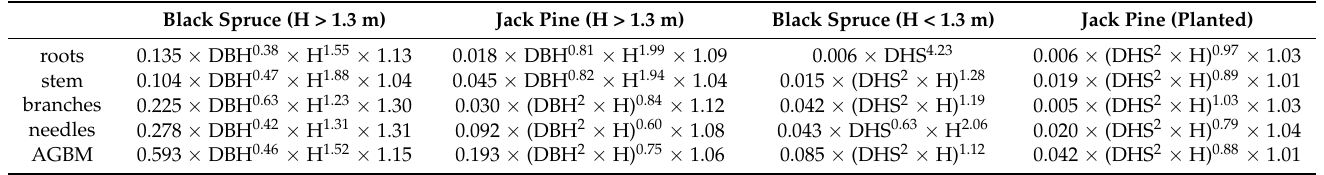
Table 6. Selected equations for each tree compartment for black spruce and Jack pine trees with H > 1.3 m ( n = 96 and 50, respectively), black spruce trees with H < 1.3 m ( n = 21) and planted Jack pine trees ( n = 28).